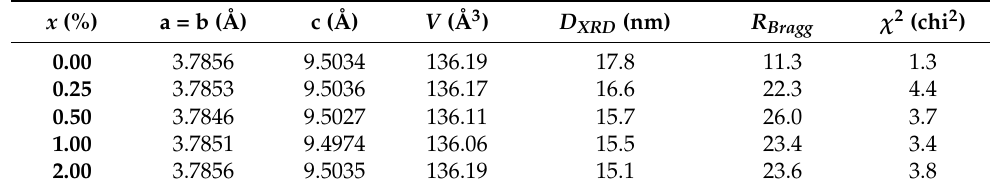
Table 1. Refined structural parameters of Ce–Sm co-doped TiO 2 NPs ( x = 0.00, 0.25, 0.50, 1.00, and 2.00%).